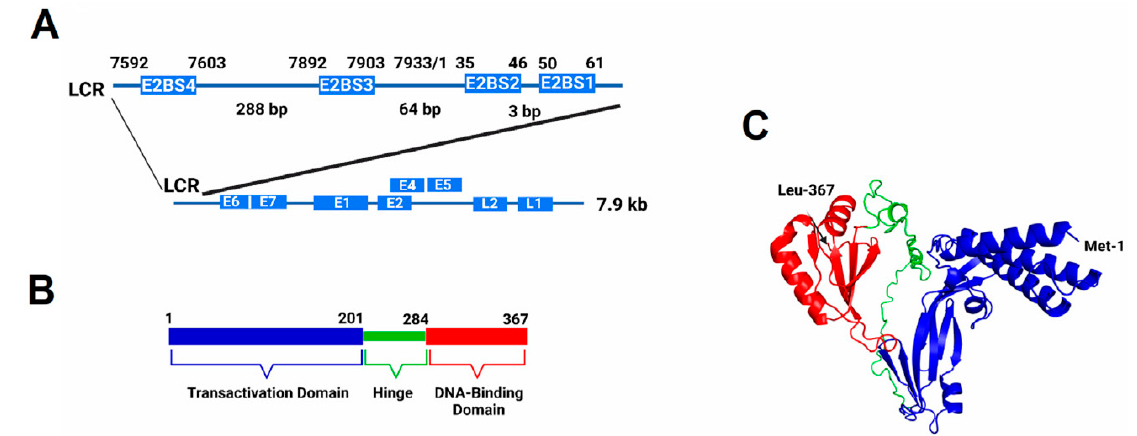
Figure 1. Structure of E2 protein, HPV-11 genome, and its predicted crystal structure. ( A ) The chromosomal location and structure of the DNA replication origin in the HPV-11 genome. The enlarge- ment of the LCR indicates the location of the four E2 binding sites (E2 BS1-4) (not drawn to scale). ( B ) Structure of the HPV-11 full-length E2 protein indicating the N-terminal transactivation, hinge, and C-terminal DNA-binding domains (drawn to scale). ( C ) A homology-based model of full-length E2 protein created using the Robe tt a Structure Prediction software (3 March 2023) at the University of Washington depicting structures of the transactivation and DNA-binding domains. The fi rst and last amino acids covered in the model are annotated by MET-1 and LEU-367, respectively.